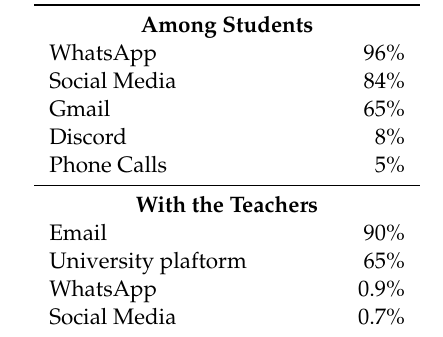
Table 3. Means of contact with other students and teachers.